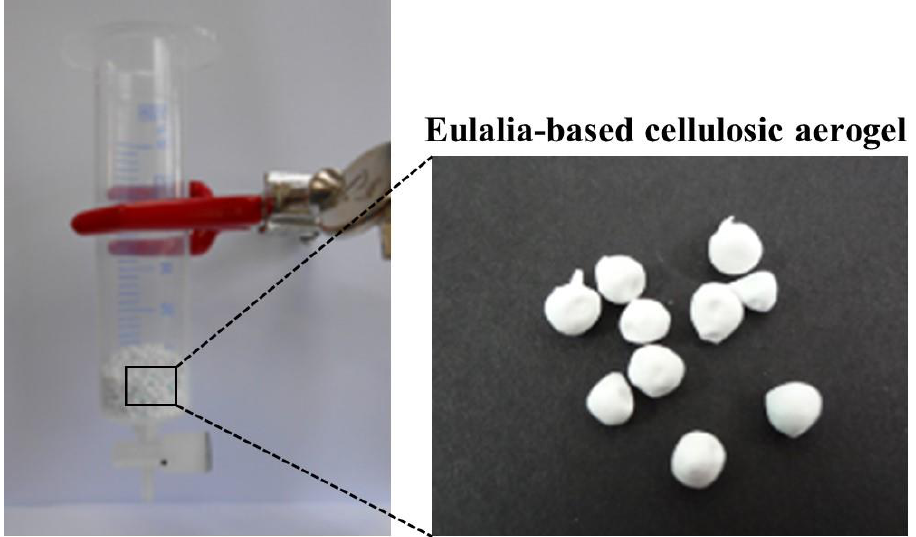
Figure 2. Eulalia-based cellulosic aerogel contained in